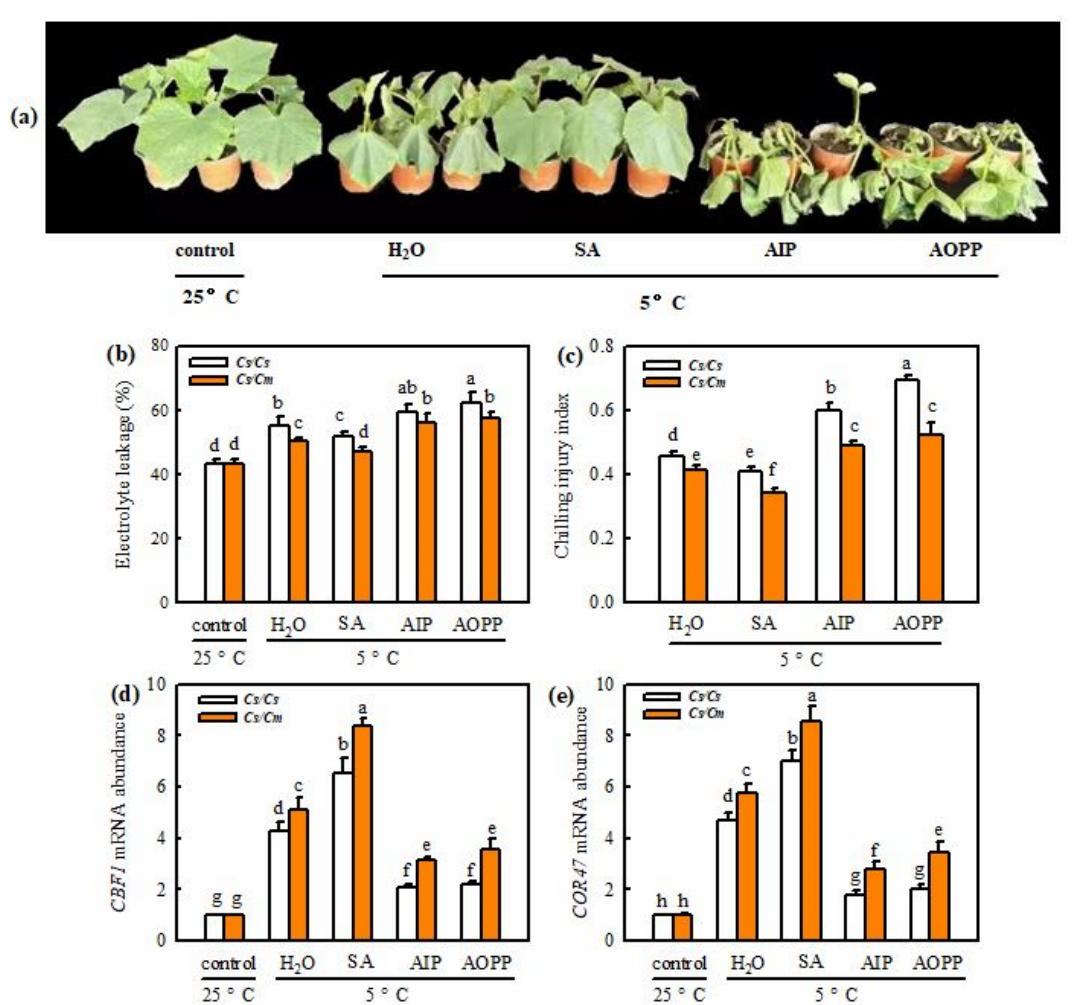
Figure 3. Involvement of SA in grafting-induced chilling tolerance. Plants with three leaves were pretreated with 1.0 mM SA, 30 µ M AIP, 0.1 mM AOPP, or deionized water (H 2 O, control) for 24 h and then exposed to chilling stress. ( a ) Phenotype of Cs / Cm plants after chilling treatment for 0 h and 72 h. ( b ) Electrolyte leakage of the Cs / Cs and Cs / Cm plants after being treated at 5 ◦ C for 0 h and 48 h. ( c ) Chilling injury index of Cs / Cs and Cs / Cm plants treated at 5 ◦ C for 72 h. ( d , e ) Relative mRNA expression of CBF1 and COR47 of Cs / Cs and Cs / Cm plants treated at 5 ◦ C for 0 h and 24 h. Data are presented as the means ± SD ( n = 3). Different letters indicate a statistical significance between samples at p < 0.05.